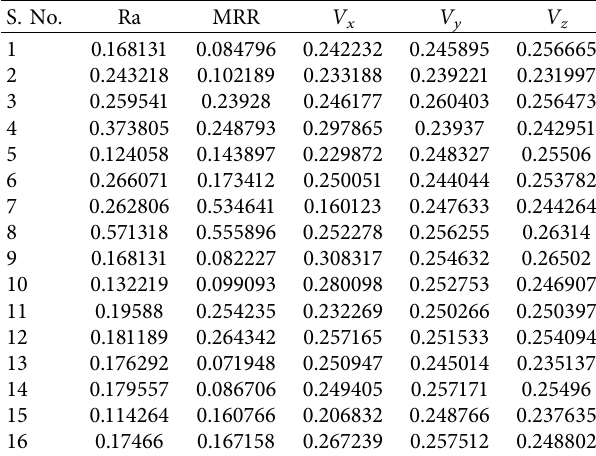
Table 6: Normalization